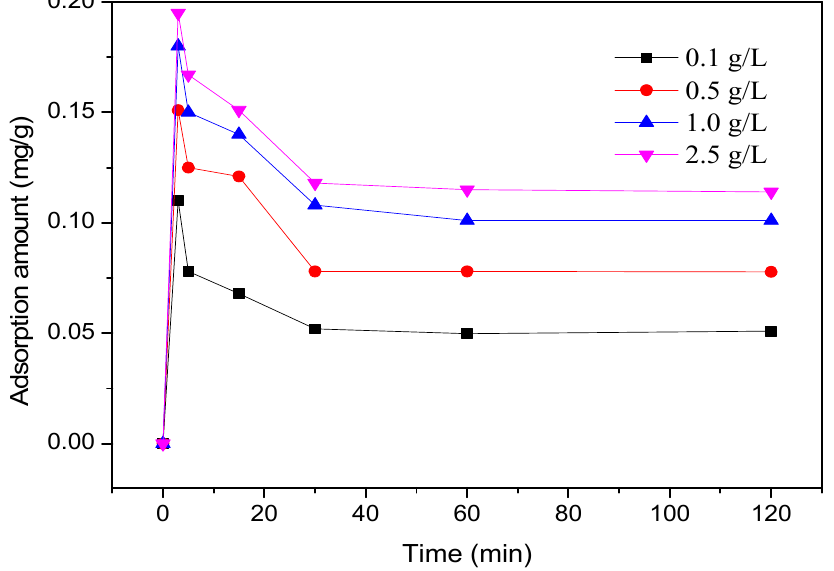
Figure 5. Adsorption behavior of four different PCE-1 concentrations in the stone powder over 120 min.